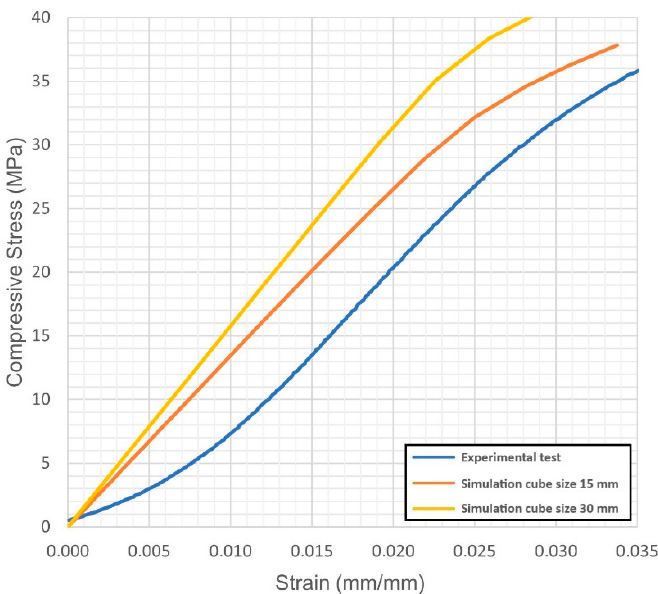
Figure 6. Condition 5, stress-strain diagram; comparisons between simulated and actual spec- imens.